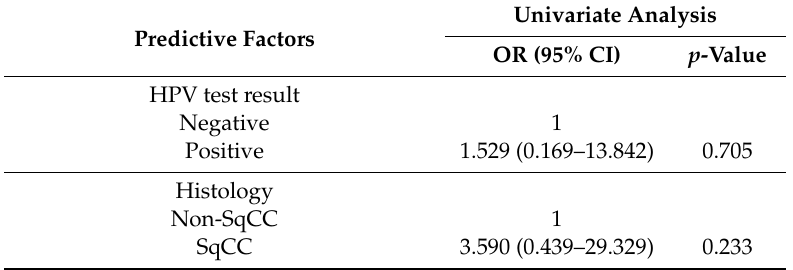
Table 4. Logistic regression analysis of predictive factors for the objective response